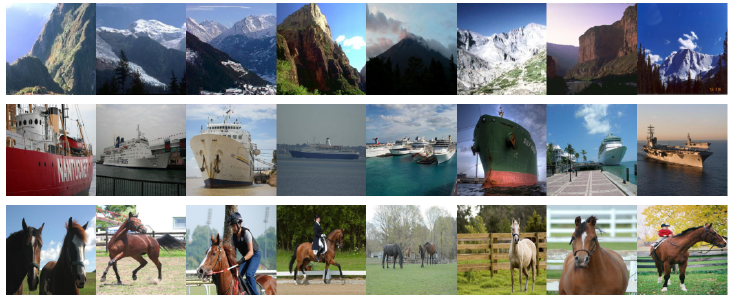
Figure 6. Eight nearest neighboring images in the test data to the determined Broden CAVs for concepts mountain, ship and